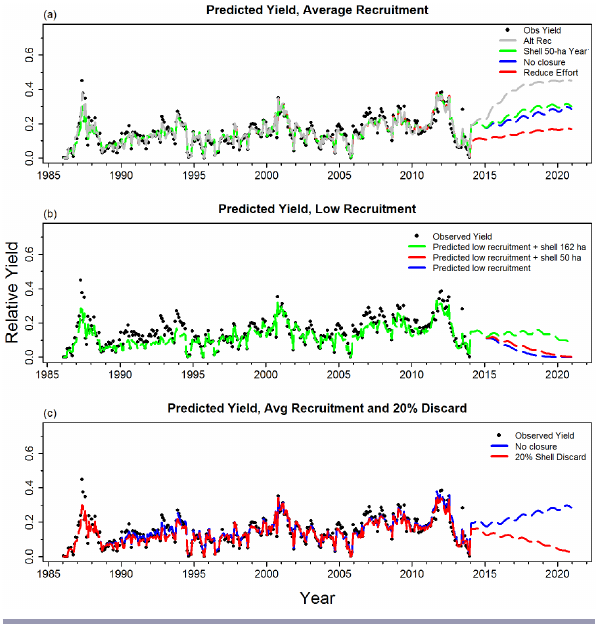
Fig. 5 . Observed (black circles) and model predicted (overlapping lines) oyster yields in Apalachicola Bay, Florida from 1986-2013. In panel a, 2013-2020 yield is predicted under three different scenarios based on 2004-2013 average annual recruitment rates. Scenario 1 (blue line, no closure) is a baseline prediction of oyster population yield allowing for average recruitment and based on survival rates and similar effort levels observed in 2004-2008. Scenario 1 also includes results from a “no closure” option assuming the alternative Beverton-Holt stock-recruitment function. Scenario 2 (red line, reduced effort) is similar to scenario 1, but also reduces fishing effort by 50% from 2013-2020. Scenario 3 (green line) assumes a shelling restoration program at a level of 50 ha per year from 2013-2017. Panel b assumes that recruitment from 2014-2020 is lower than the 2004-2013 average and similar to average recruitment estimated during 2012-2013. Three low- recruitment scenarios are evaluated: a “no action” scenario (blue line), a low shelling area option of 50 ha for 4 years (red line), and a high shelling area option of 162 ha for 4 years (green line). Panel c is similar to panel a with the same scenario 1 (blue line, no closure) and a scenario 2 that assesses yield recovery under a situation where shell is removed at a rate of 20% a year from storms or fishery